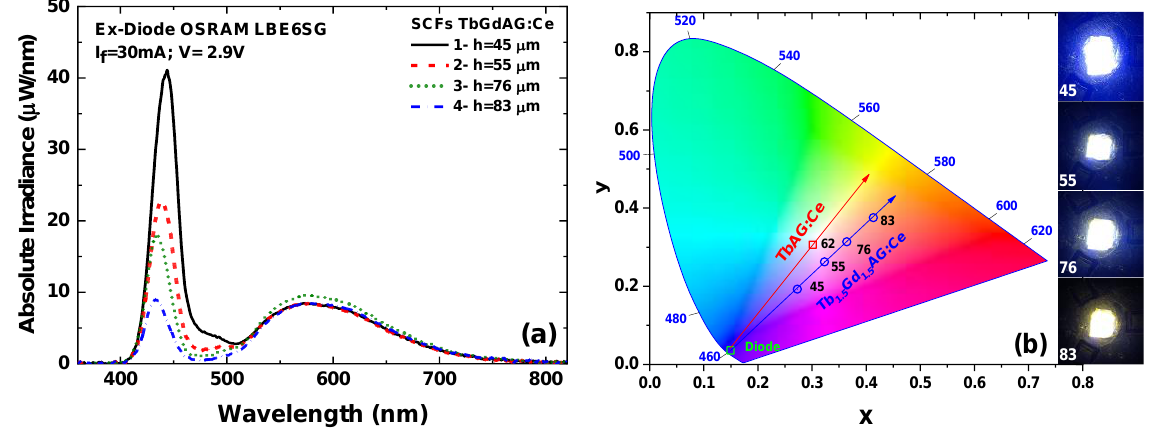
Figure 7. Spectral performance ( a ) and color coordinates ( b ) of TbGdAG:Ce SCFs under blue LED excitation plotted on CIE chromaticity diagram.